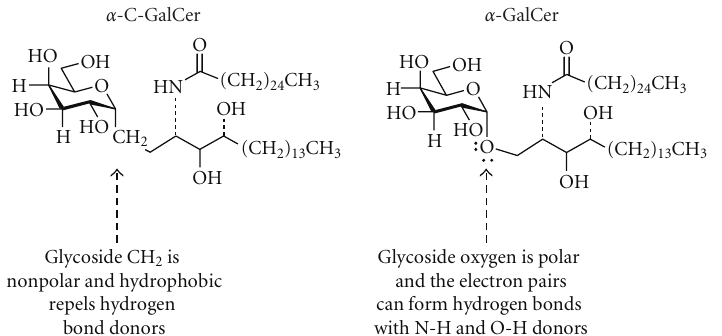
Figure 1: Structural comparison between α -C-GalCer and α -GalCer showing the main di ff erences between the two molecules. Glycoside CH 2 is nonpolar and hydrophobic; it repels hydrogen bond donors. In contrast, glycoside oxygen is polar, and the electron pairs can form hydrogen bonds with N–H or O–H